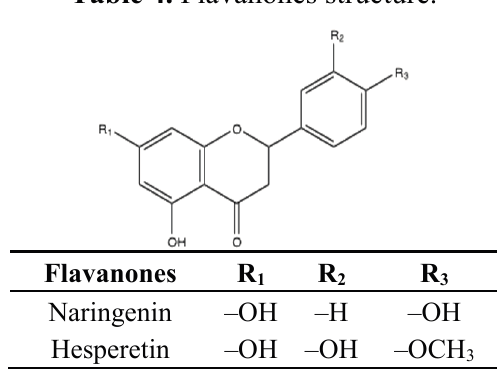
Table 4. Flavanones